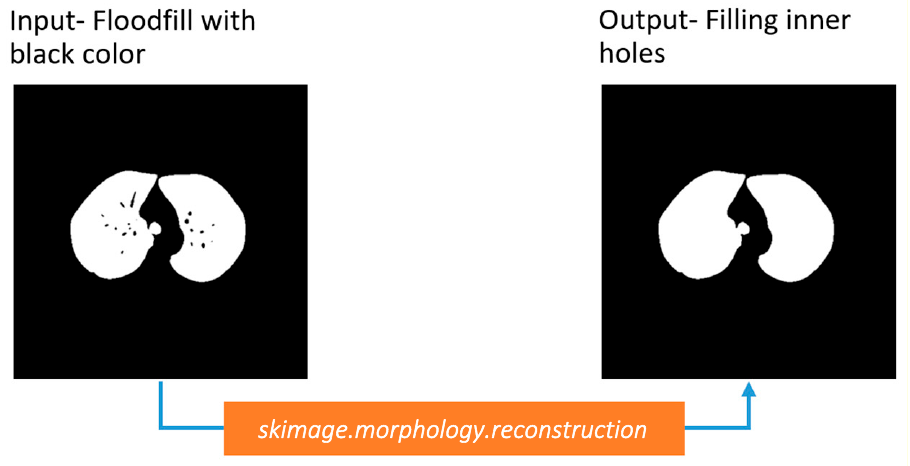
Figure 16. Filling inner holes of the binary mask.